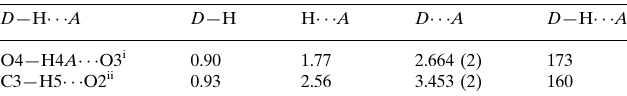
Hydrogen-bond geometry (A˚ , (cid:1)